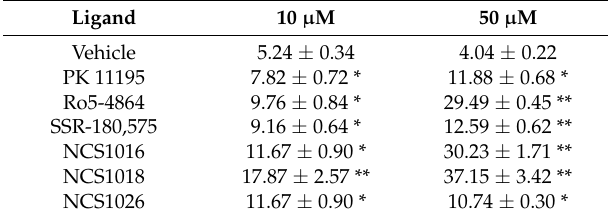
Table 3. Quantification of sorbitol-induced hemolysis t 1/2 values in the presence of different TSPO ligands.